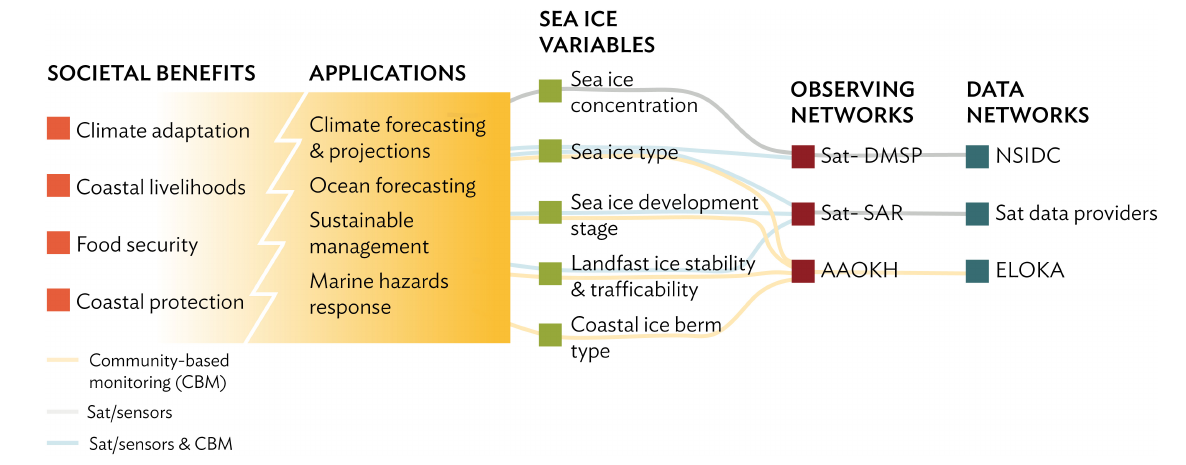
FIGURE 2 | (Adopted from Lindstrom et al., 2012) Example of observing network design and implementation as seen through the lens of a top-down approach based on Starkweather et al. (2018). Shown is the link between societal benefit areas, EOVs, and observing and data management systems for the GOOS FOO (Lindstrom et al., 2012) as applied to Arctic sea-ice observations. Abbreviations: DMSP, Defense Meteorological Satellite Program; SAR, Synthetic Aperture Radar; NSIDC, National Snow and Ice Data